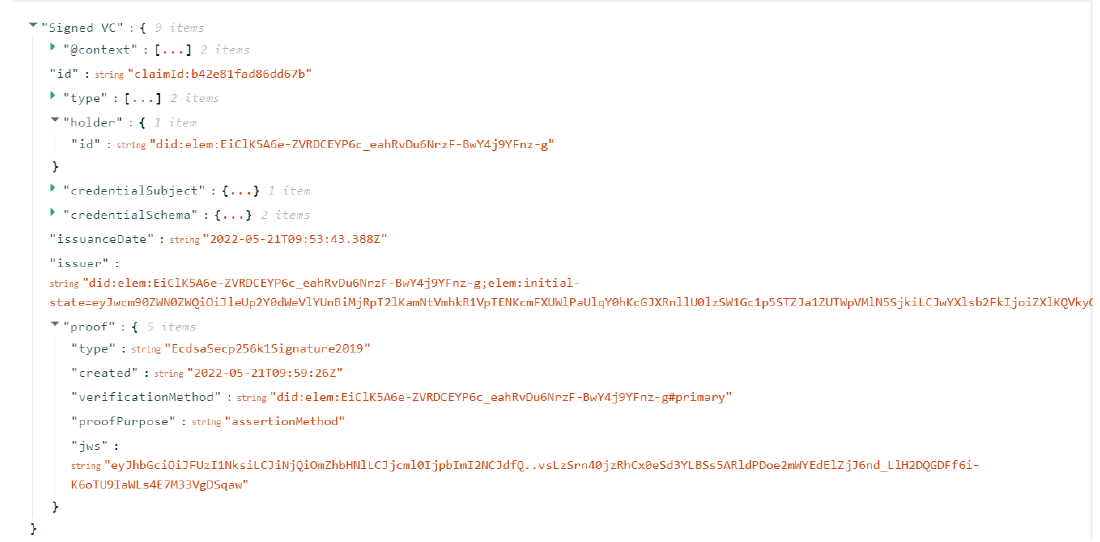
Figure 4. Demonstration of signed verifiable credential with cryptographic proofs.